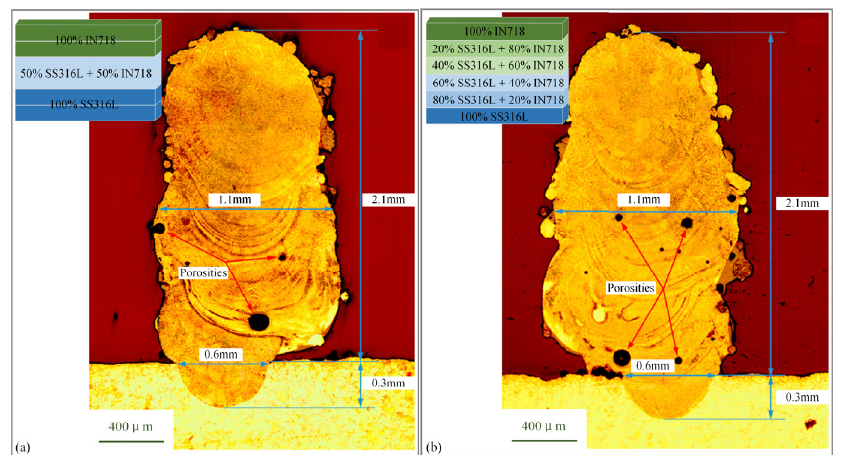
Figure 6. The cross-section of SS316L/IN718 samples under different gradient types fabricated by DLMD: ( a ) Composition changed every two layers, ( b )Composition changed every one layer. [52].